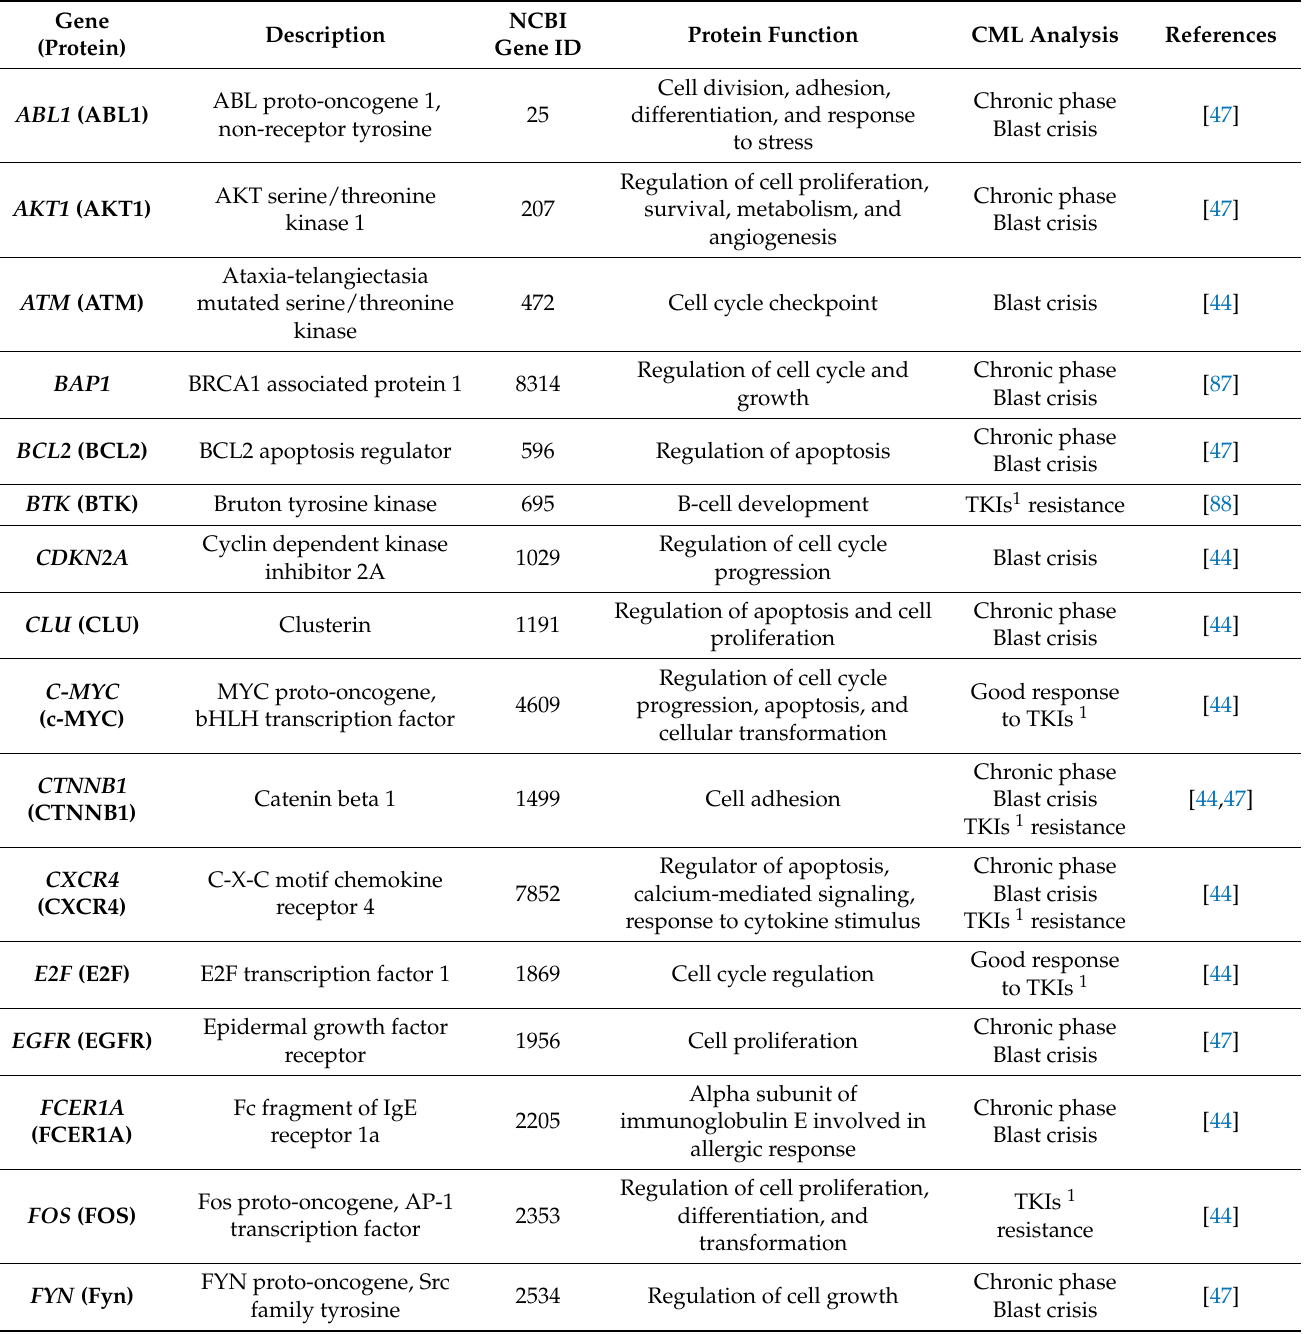
Table 1. Genes whose expression is altered in